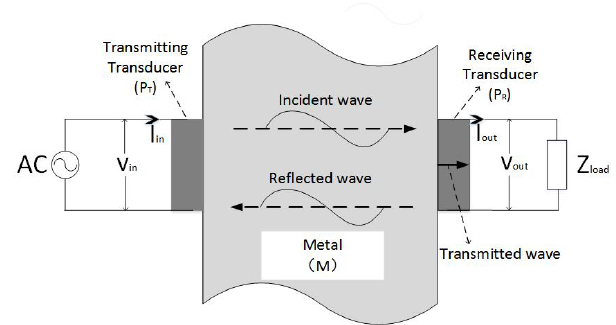
Figure 2. Electro-acoustic-electric channel